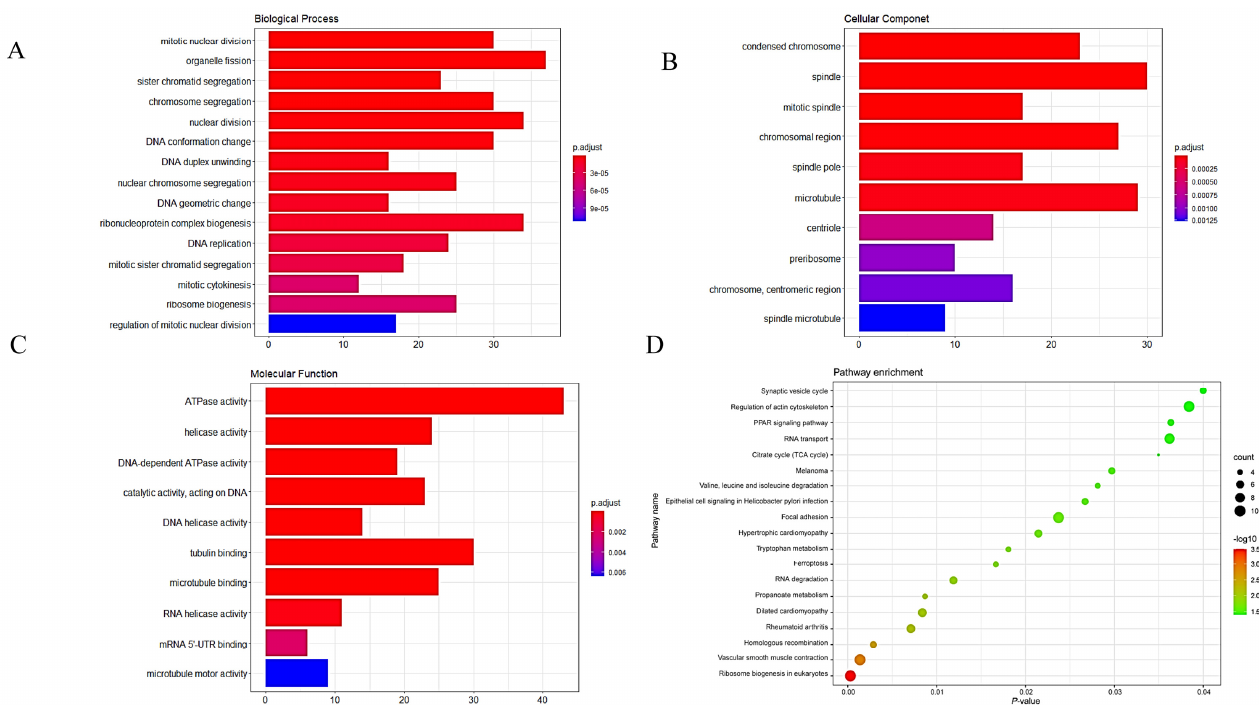
Figure 3. GO and KEGG analyses of DEGs. ( A – C ) GO analyses of DEGs. ( D ) KEGG analysis of DEGs. BP, biological process; CC, cellular component; MF, molecular function.